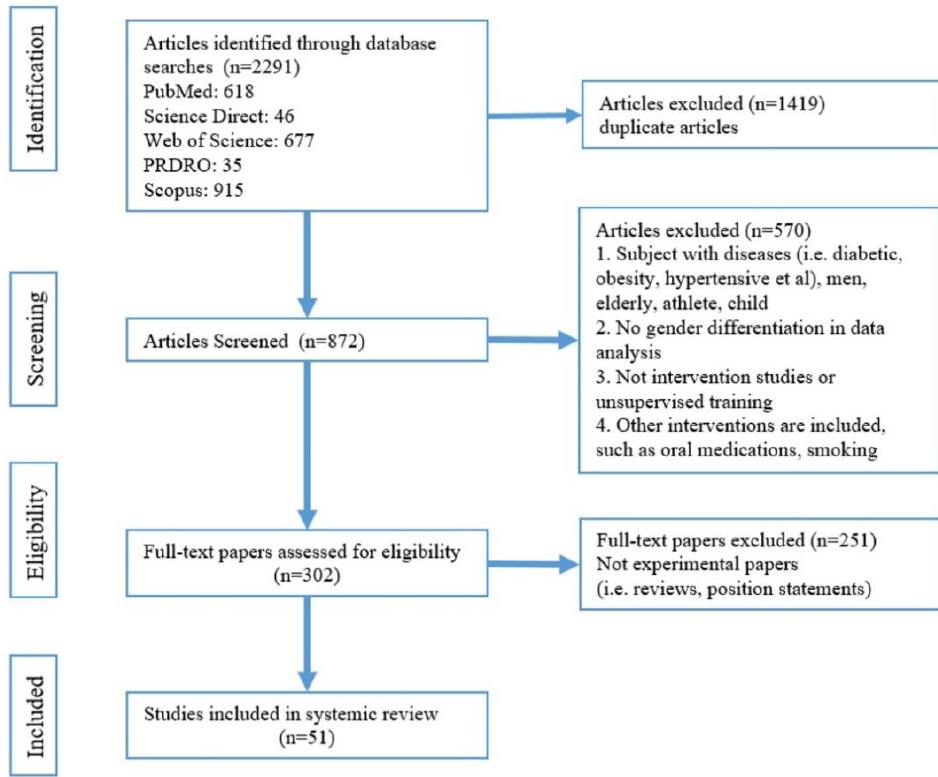
Figure 1. Flowchart for study selection.